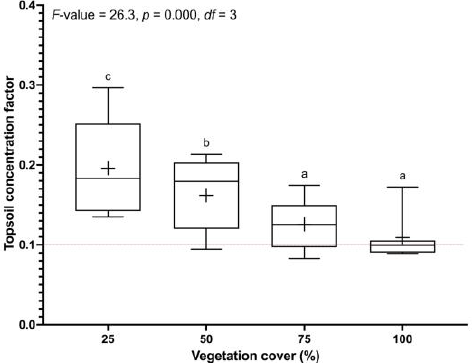
Figure 5. Topsoil concentration factors (TCFs, 0–5/0–50 cm) of volumetric soil organic carbon (SOC) density (kg C/m 3 ) in ten sites of sabkhas with different vegetation covers along the southern Red Sea coast of Saudi Arabia. F -value represents the one-way analysis of variance (ANOVA); df = degrees of freedom; different letters are significantly different at p < 0.05 according to Tukey’s HSD (Honest Significant Difference) test. “+” sign represents the mean.